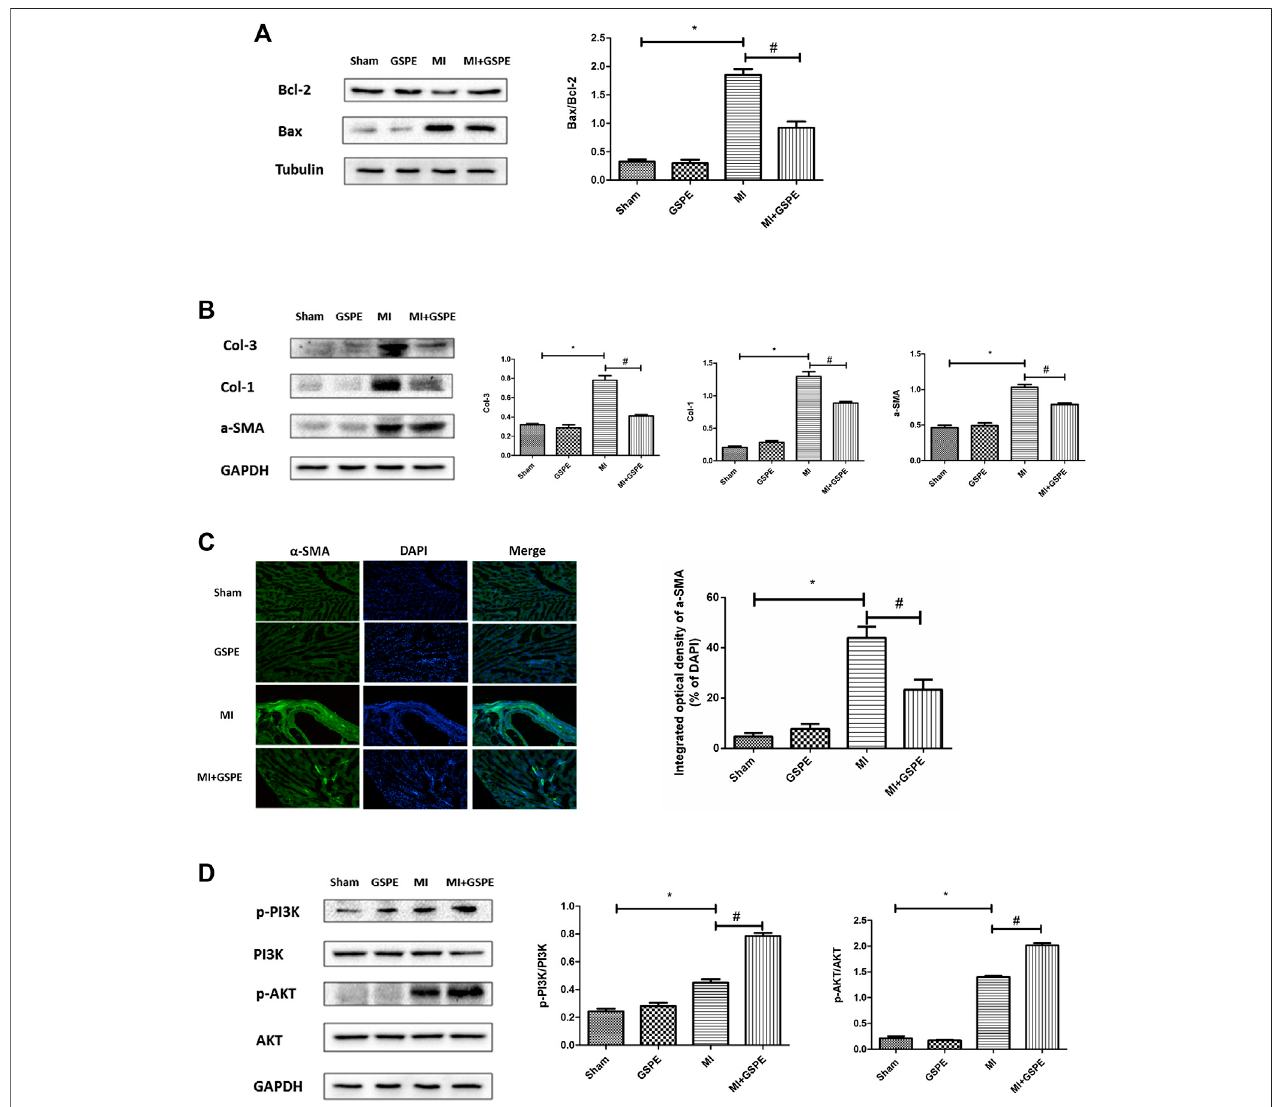
FIGURE 3 | GSPE attenuated MI induced apoptosis and myocardial fi brosis by activating PI#K/AKT pathway. (A) Effects of GSPE on the levels of Bax and Bcl-2 evaluatedbyWestern blotanalysis. (B) EffectsofGSPEonthelevelsofCol-1, Col-3 anda-SMA evaluatedbyWestern blotanalysis. (C) Immuno fl uorescensestainingof a-SMA. (D) Effects of GSPE treatment on cardiac levels of p-PI3K, PI3K, p-AKT and AKT evaluated by Western blot analysis. *Signi fi cant difference compared with the control group. p < 0.05; #signi fi cant difference compared with the MI group, p < 0.05, n (cid:2) 3 per group.